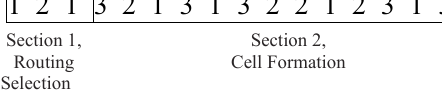
Fig. 1. Configuration of a